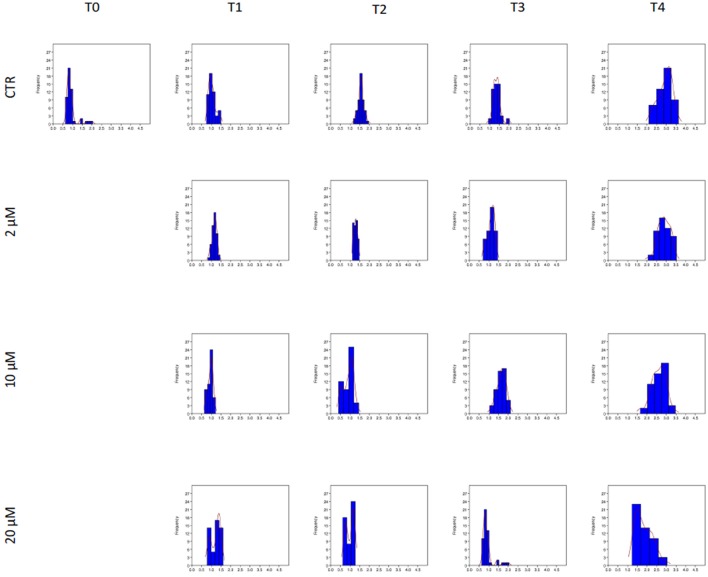
Effect of Aminopurvalanol A on actin polymerization. The histograms represent the subpopulation of spermatozoa individuated by Kernel Density Estimation. On x axis are reported the values of fluorescence emitted by spermatozoa stained with FITC-conjugated falloidin, expressed as arbitrary units.